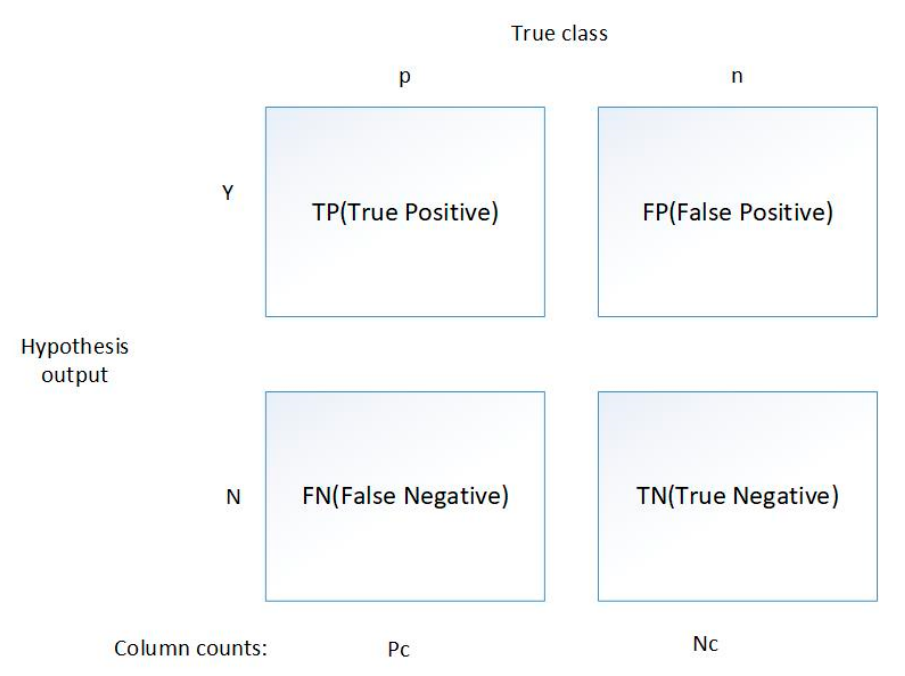
Figure 7. Confusion matrix.